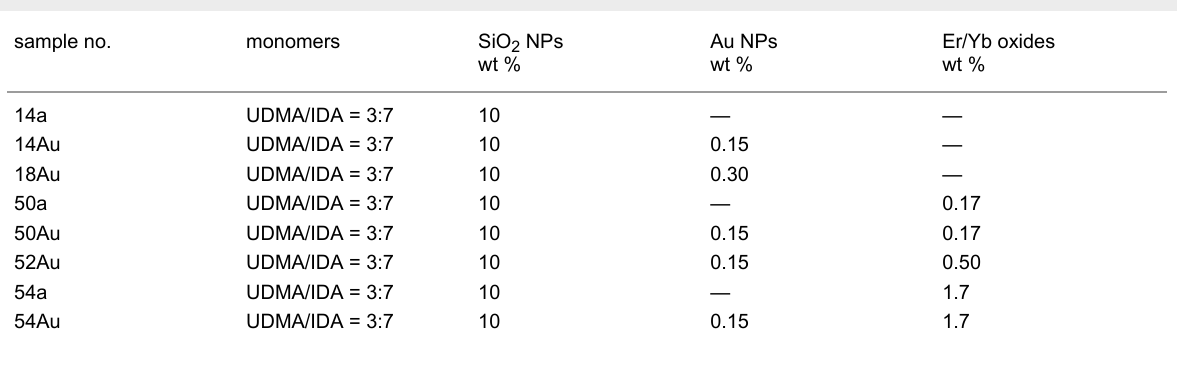
Table 2: Composition of the prepared composites. sample no.